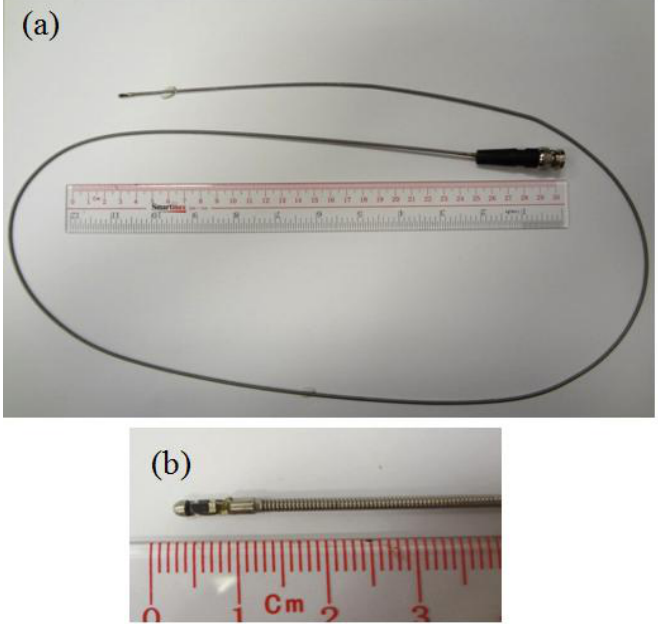
Figure 4. The prototype of a 10 MHz rotatable ultrasonic ( a ) catheter and ( b ) enlarged probe [64].